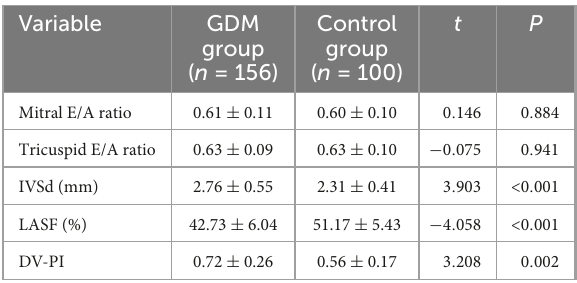
TABLE 2 Comparison of echocardiography parameters between two